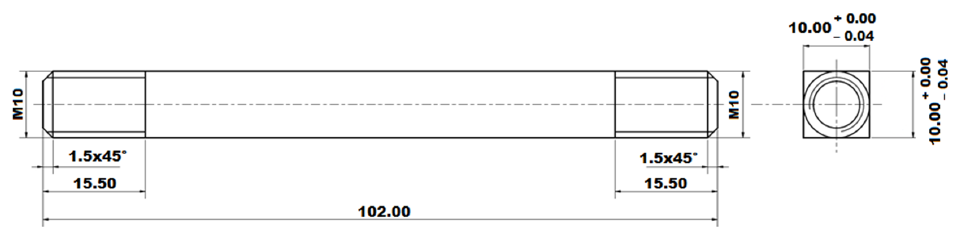
Figure 2. Drawing of the sample for simulations in Gleeble (in mm)